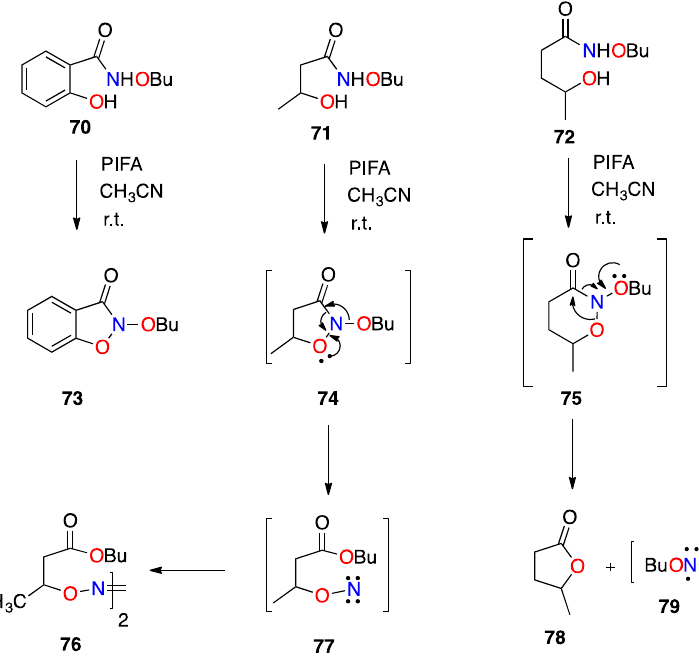
Scheme 15. HERON reactions of γ -oxazinolactam 71 and δ -oxazinolactam 72 .